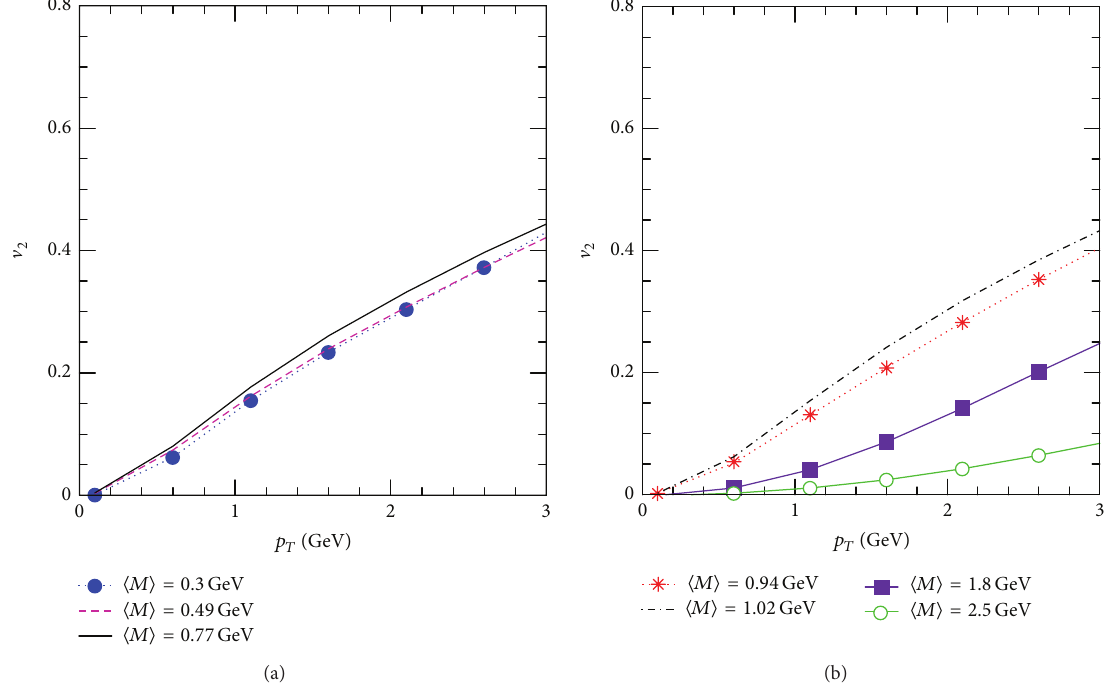
Figure 41: Total elliptic flow as function of 𝑝 𝑇 for various mass